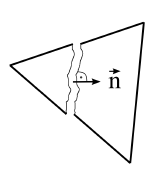
Figure 5. Separated triangle caused by a crack